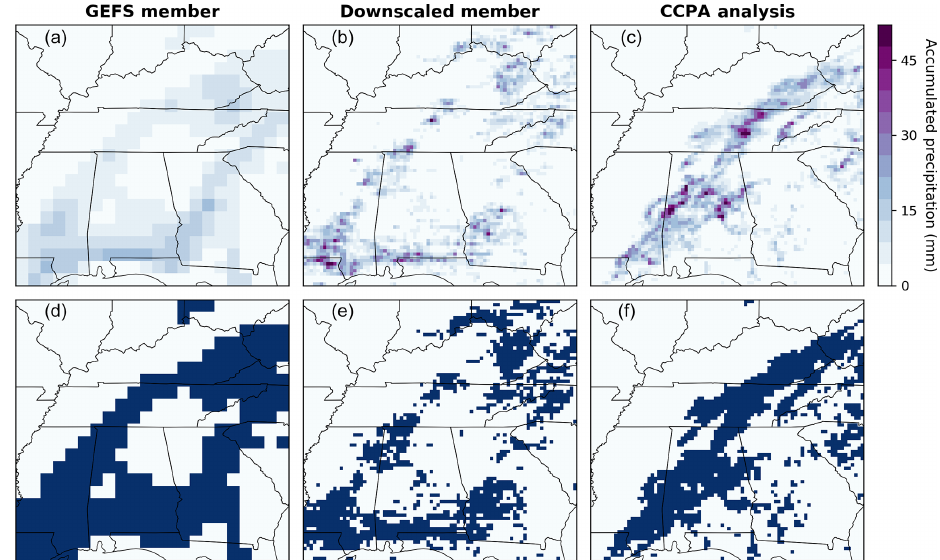
Figure 7. Examples of different data fields for 6h precipitation accumulation on 24 July 2004 (a–c) and corresponding 5mm binary ex- ceedance fields ( d–f ; dark blue regions indicate threshold exceedance). From left to right: coarse-scale GEFS ensemble member, the same member downscaled to the analysis resolution, and the corresponding CCPA